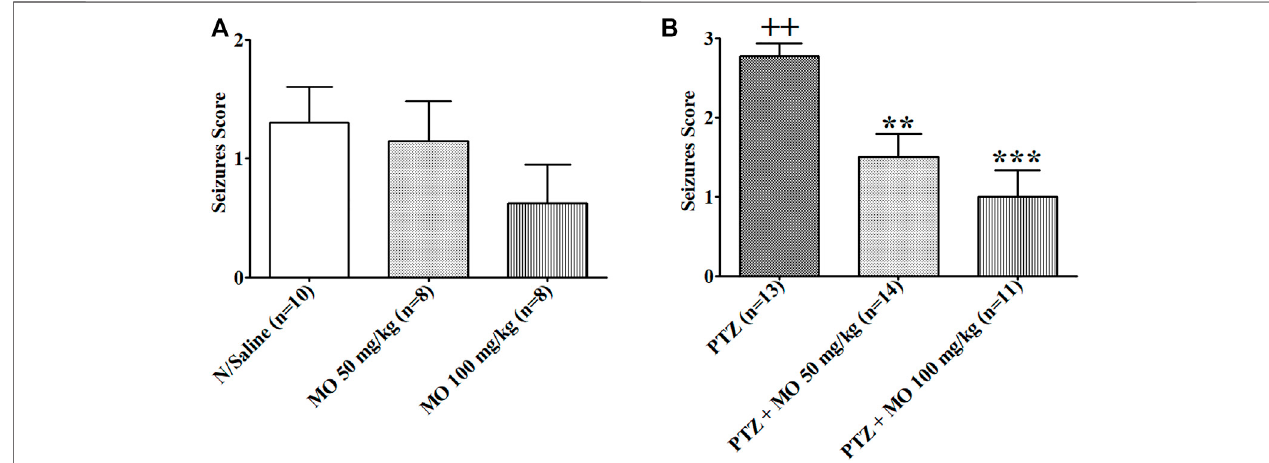
Enhanced duration of immobility was observed in rats that received repeated subconvulsive doses of PTZ in FST. The enhanced immobility time was not signi fi cant compared to saline treated rats (N/Saline vs PTZ). The effects of PTZ on duration of the immobility in the FST were signi fi cantly [F (2, 18) (cid:2) 11.73, * p < 0.05 (PTZ vs PTZ + MO 50 mg/kg); ** p < 0.01 (PTZ vs PTZ + MO 100 mg/kg)] reduced with concurrent administration of MO ( Figure 7 ).